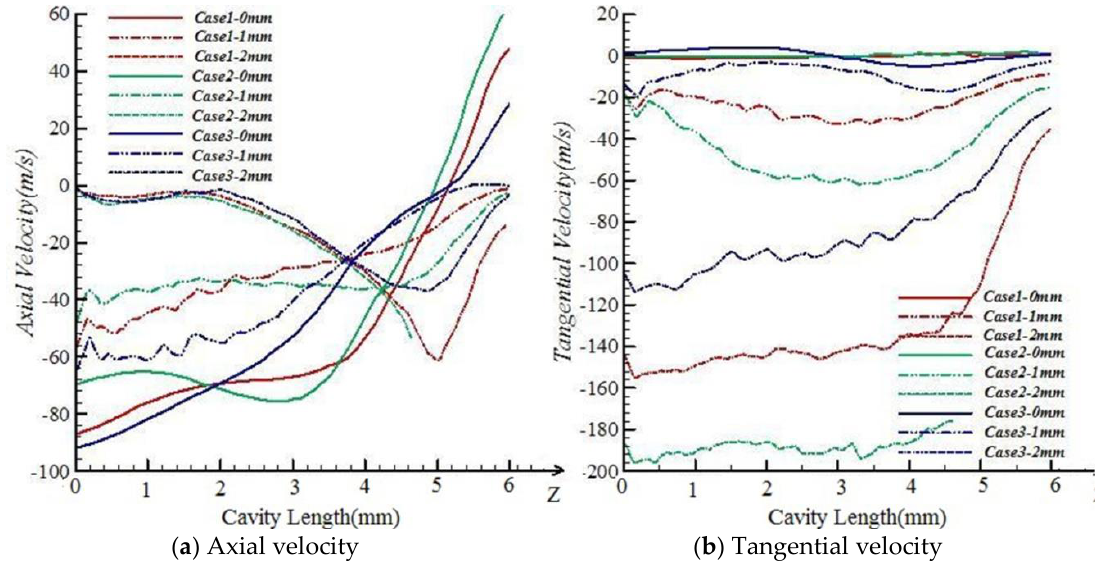
Figure 7. Velocity comparisons among Case1, Case2, and Case3.